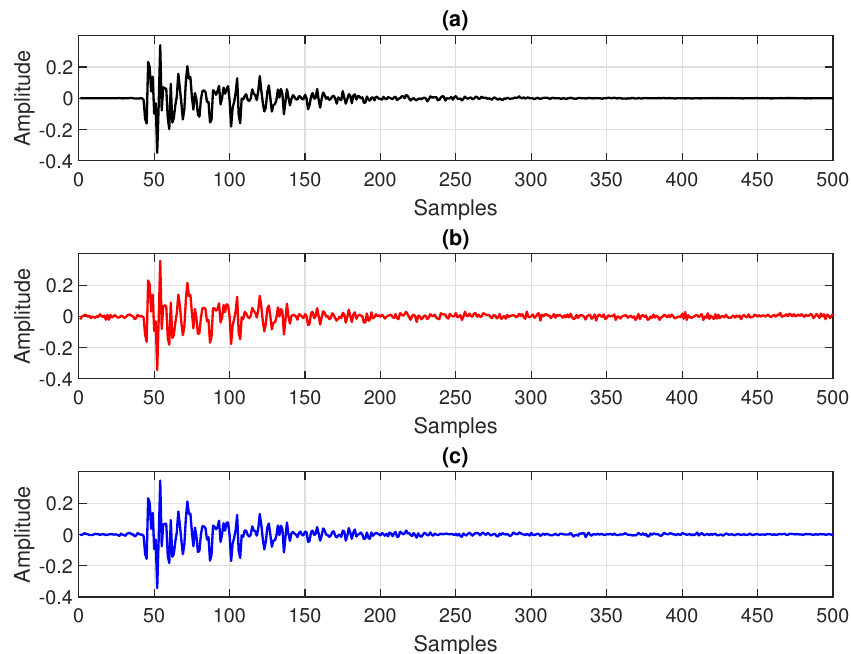
Figure 16. Performance of the conventional RLS filter [with λ = 1 − 1/ ( KL /2 ) ] and the RLS-SF [with λ 1 = 1 − 1/ ( 2 KPL 1 ) , λ 2 = 1 − 1/ ( 2 KPL 2 ) , and P = 8], using K = 10, for the identification of the acoustic echo path from Figure 1c. ( a ) The true acoustic impulse response, ( b ) estimated impulse response (after 5 s) with the conventional RLS filter, and ( c ) estimated impulse response (after 5 s) with the RLS-SF. Other conditions are the same as in Figure